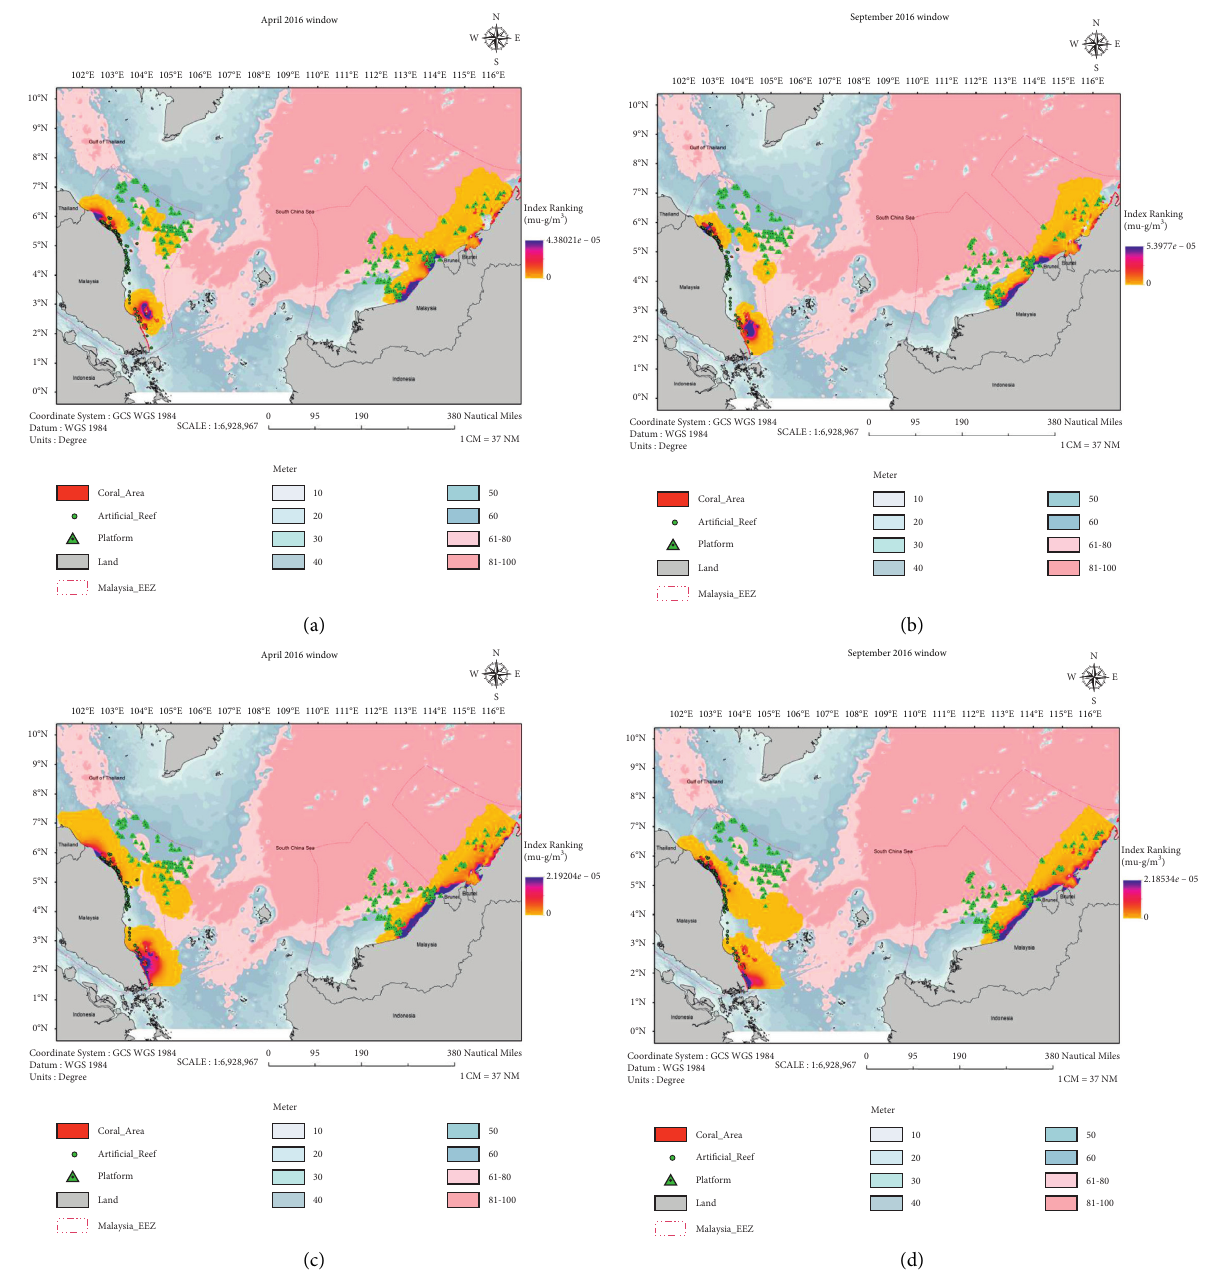
Figure 10: Integration of spatial data for April and September windows. The dispersion of the coral larvae shown at (a, b) 30 days and (c, d) 100 days after spawning